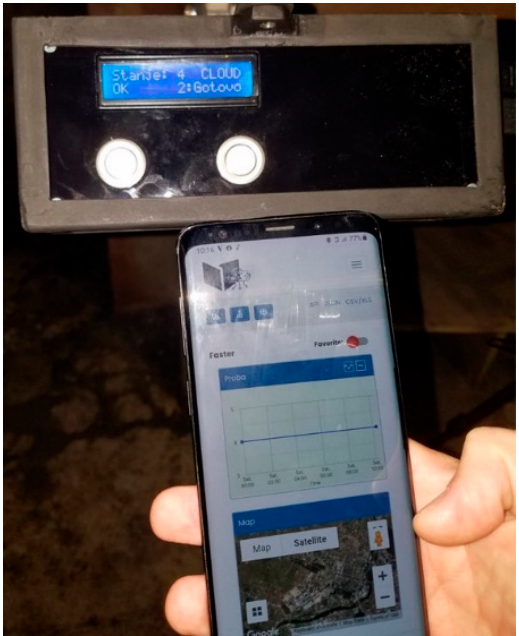
Figure 11. Diagram from the IoT cloud platform shown on the mobile phone.